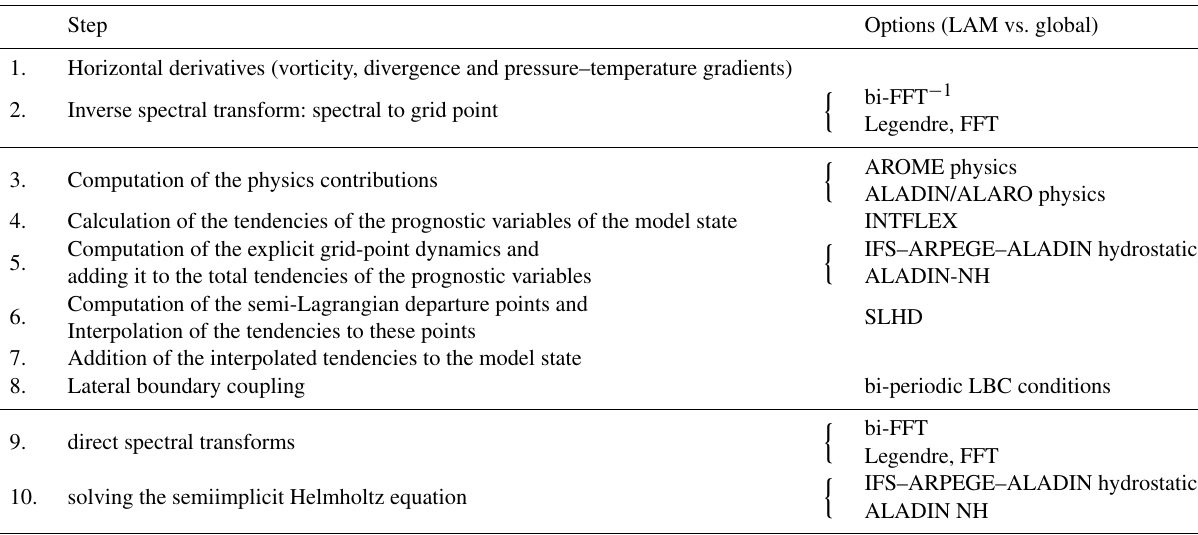
Table 1. Schematic overview of the time-step algorithm of the configurations of the ALADIN System and the choices that differentiate them with respect to the global ARPEGE